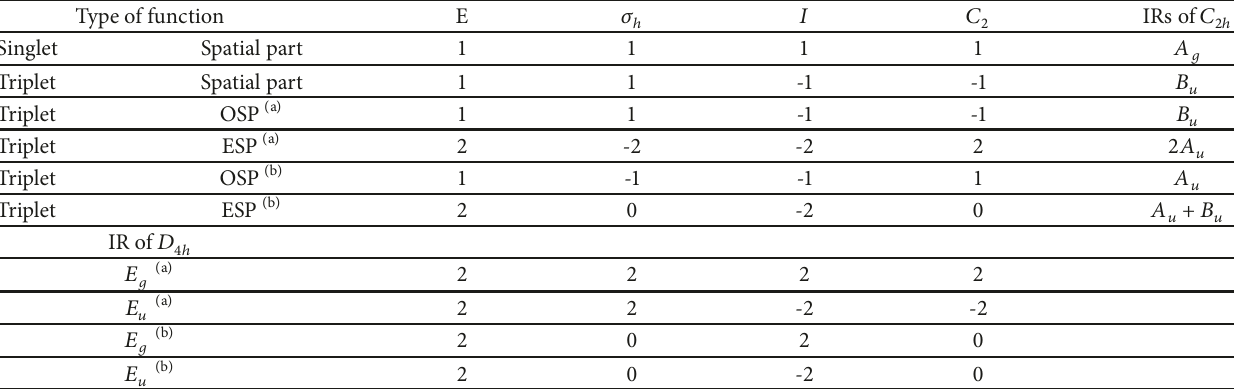
Table 3: Charactersfor singlet and triplet pairs on symmetry planes in a BZ of the space group with point group 𝐷 4ℎ (top part) and characters of IR 𝐸 𝑢 of 𝐷 4ℎ on these two types of planes (bottom part). Type of function E 𝜎 ℎ Spatial part